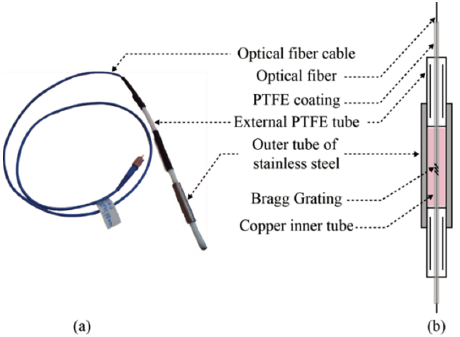
Figure 1. ( a ) Photography of the prototype with one sensing element; ( b ) Scheme of the FBG sensing